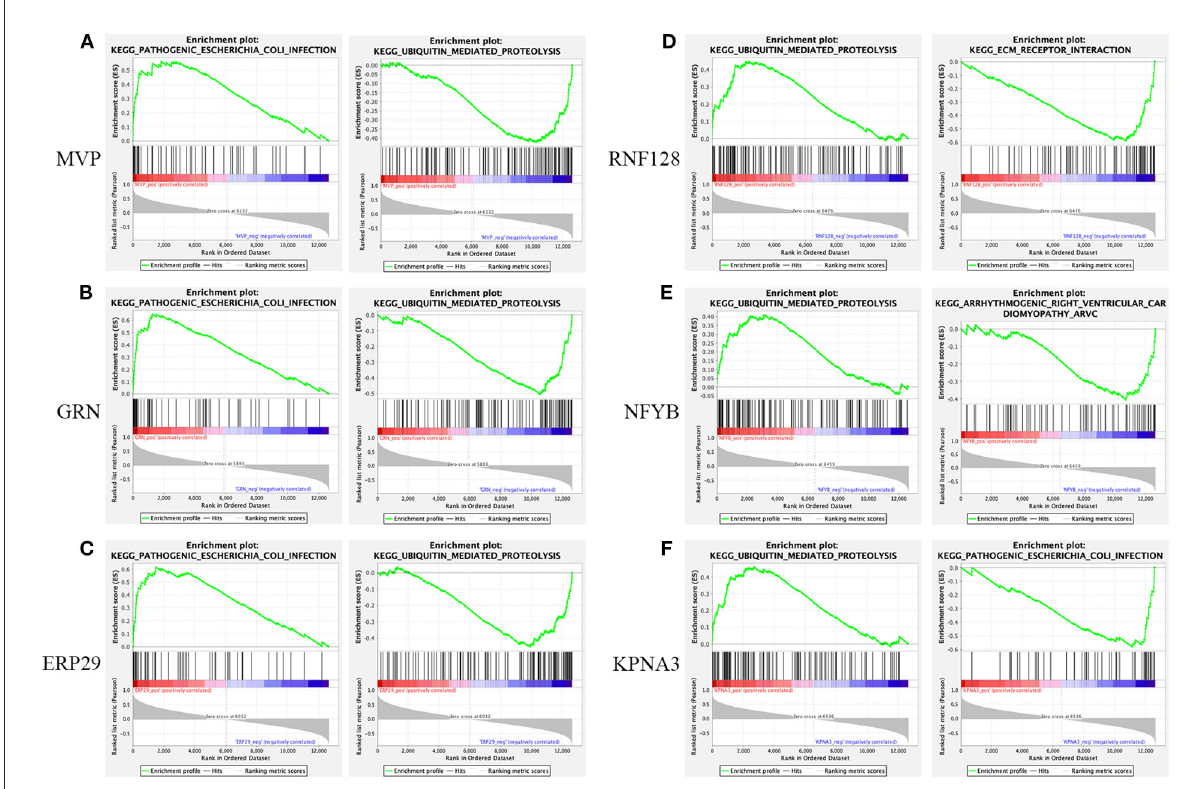
FIGURE7 Gene set enrichment analysis. KEGG entries most positively and negatively linked to MVP (A) , GRN (B) , ERP29 (C) , RNF128 (D) , NFYB (E) , and KPNA3 (F)